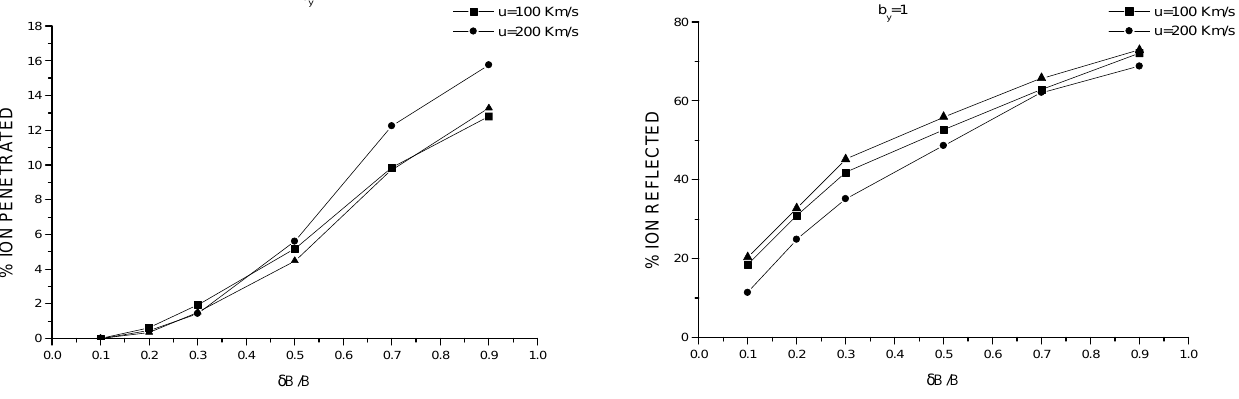
Fig. 11. The number of penetrating ions as a percentage of the total number of ions launched, as a function of the fluctuation level for one value of the shear parameter b y = 1 . 0 and for three values of the injection velocity u .